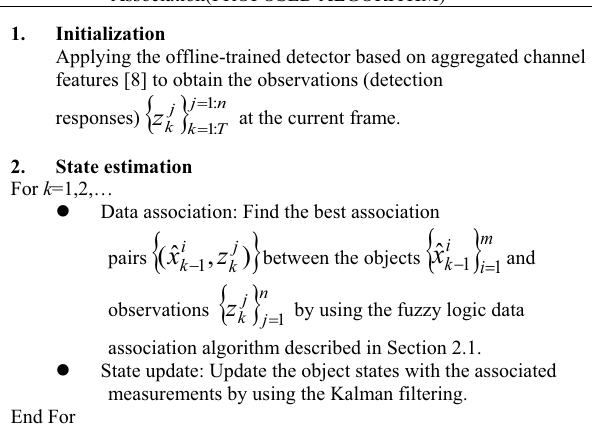
Figure.2 Membership functions for the fuzzy sets of